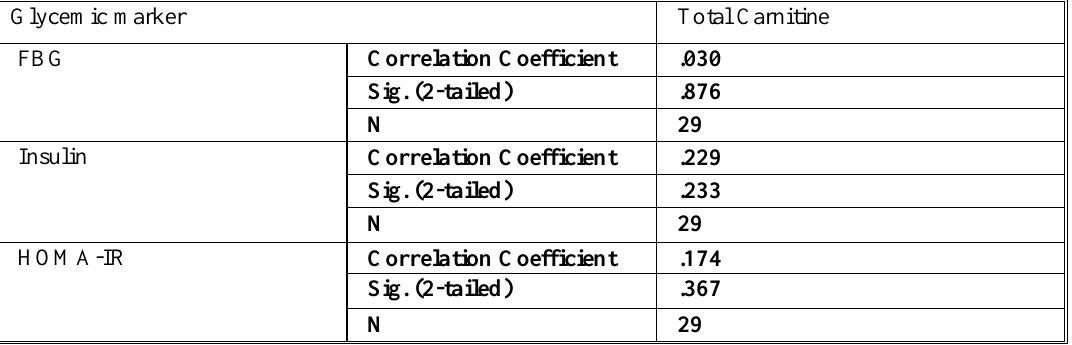
Table 2. Correlations between glycemic markers (FSG, Insulin and HOMA-IR) with serum total